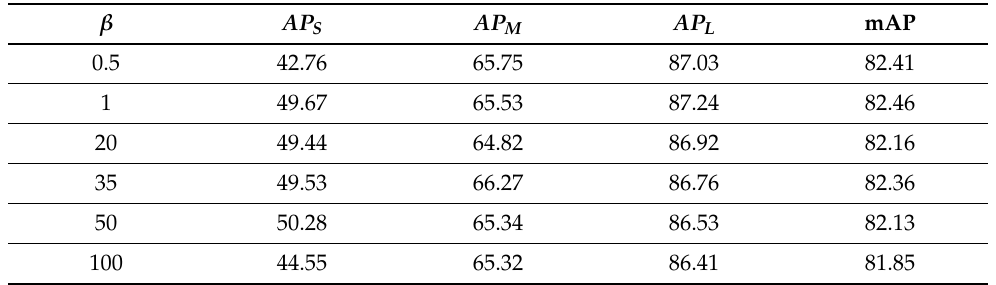
Table 4. The impact of different β values in SBFC. We perform evaluation on the test dataset of PASCAL